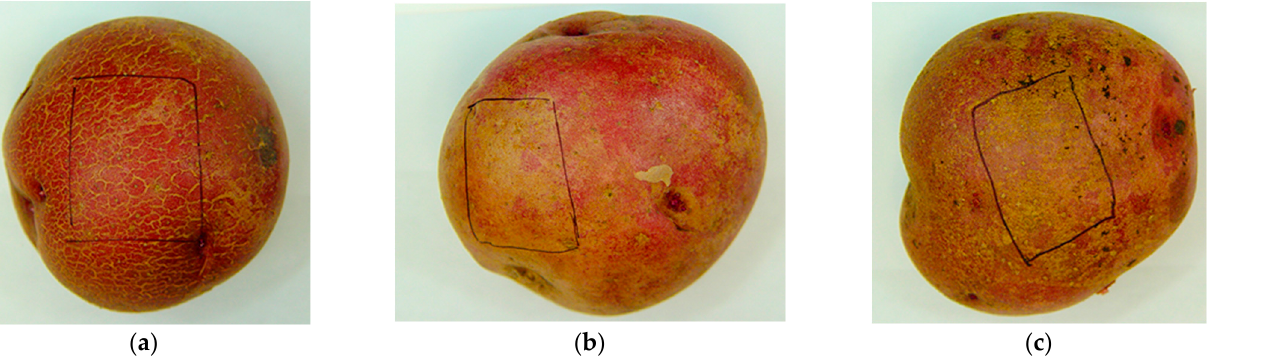
Figure 1. Tuber skin blemishes found on Dark Red Norland, as shown in the marked areas. ( a ) Surface cracking (SC); ( b ) silver patch (SP); ( c ) russeting (R). As a drought-sensitive plant, adequate soil moisture is suggested to be maintained at all stages of potato development [14]. Water stress may inhibit or even completely stop one or more physiological processes, such as transpiration, photosynthesis, cell enlargement, and enzymatic activities [15]. Limited irrigation at different stages of potato growth results in earlier crop maturity and decreases plant growth, tuber yield, the number of tubers per plant, and tuber size and quality [16,17]. Drought during the periods of tuber initiation and bulking has the most drastic effect on the yield [16]. Smaller tuber sizes and increased declined and no irrigation occurred during the tuber initiation [18]. The effects of drought tuber physiological development could include decreases in tuber number, increases in misshapen tubers, reduced tuber dry matter, and reduced water content